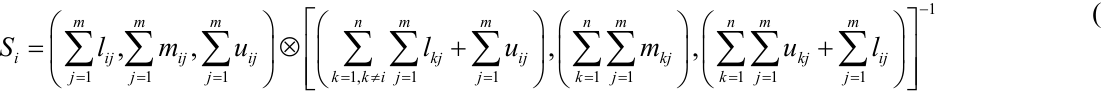
Triangular fuzzy conversation scale (Anagnostopoulos et al., 2007) Order Linguistic values Triangular fuzzy numbers